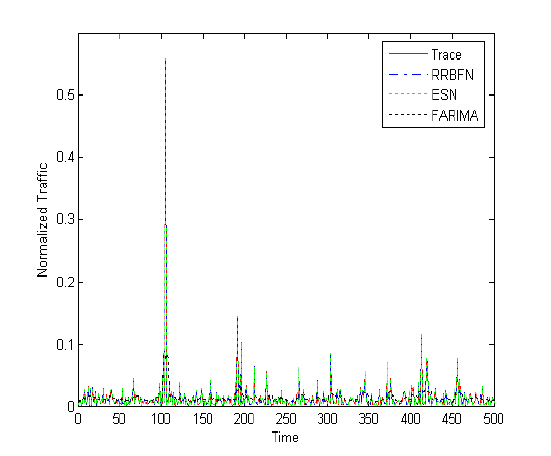
Fig. 5 . 10 – Step Traffic Prediction (1 –Second